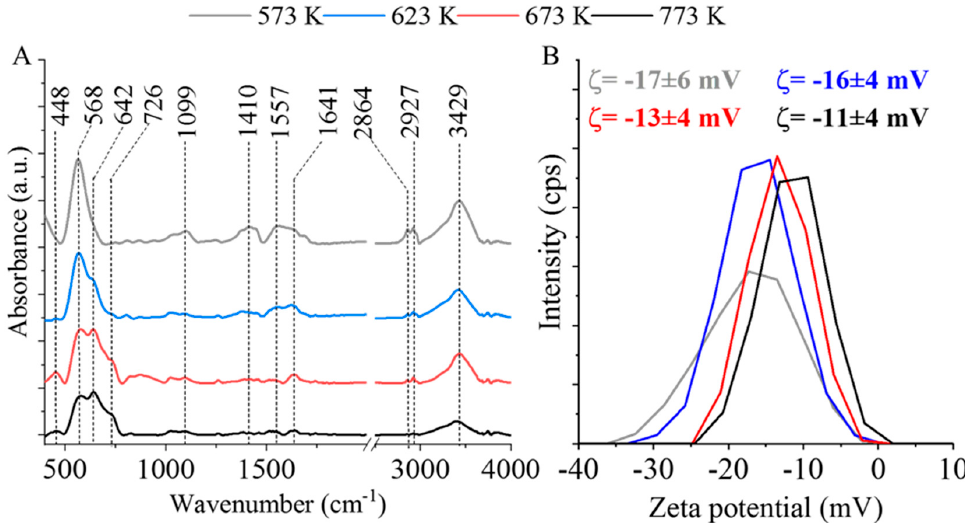
Figure 3. FTIR spectrum ( A ) and zeta potential distribution ( B ) of the nanoparticle samples produced at four different temperatures.